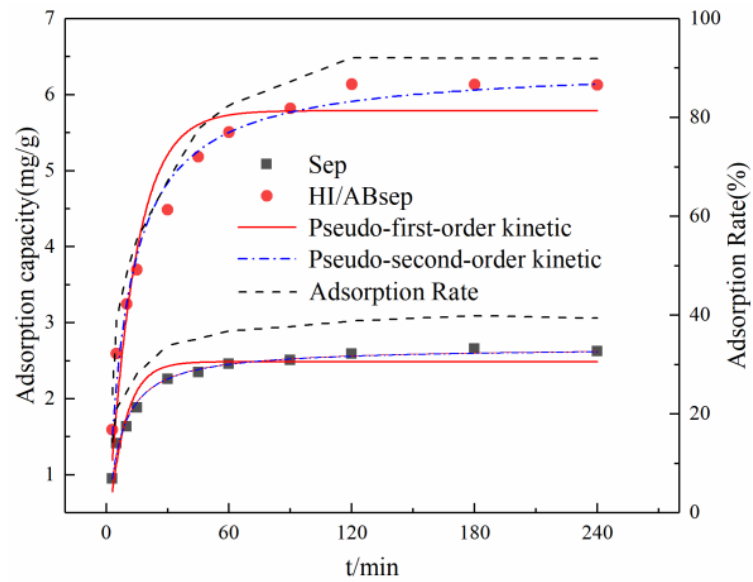
Figure 4. Adsorption kinetics of Sep and HI/ABsep.